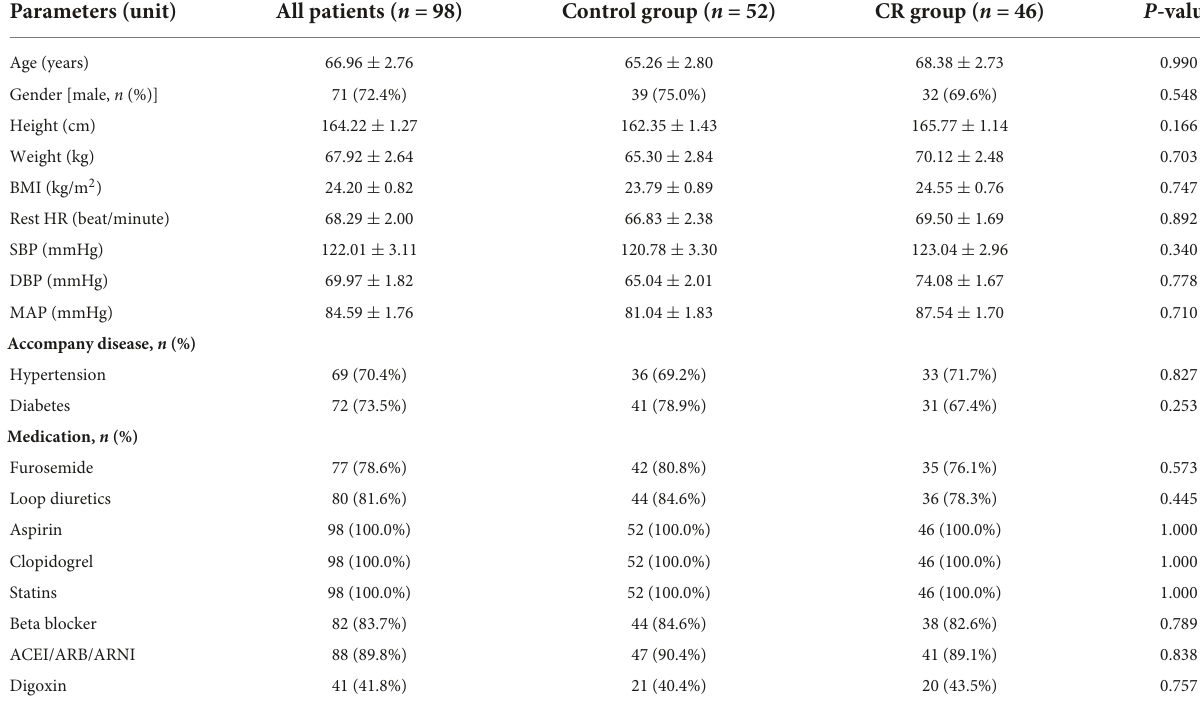
TABLE 1 Comparison of baseline clinical characteristics of patients.